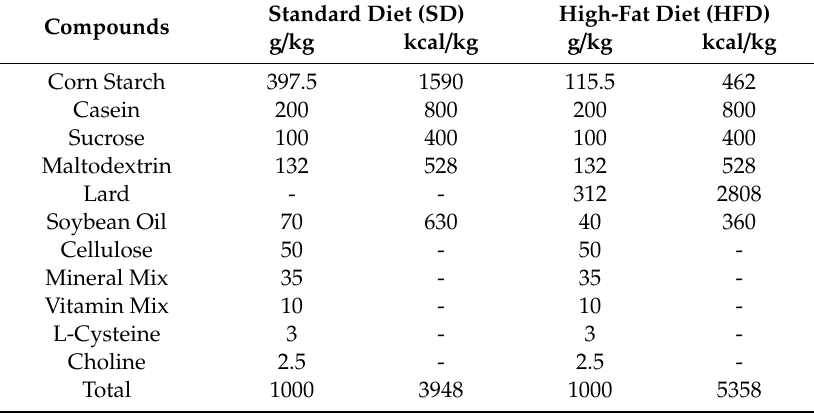
Table 1. Composition of the standard diet (SD) and high-fat diet (HFD). Standard Diet (SD) High-Fat Diet (HFD) Compounds